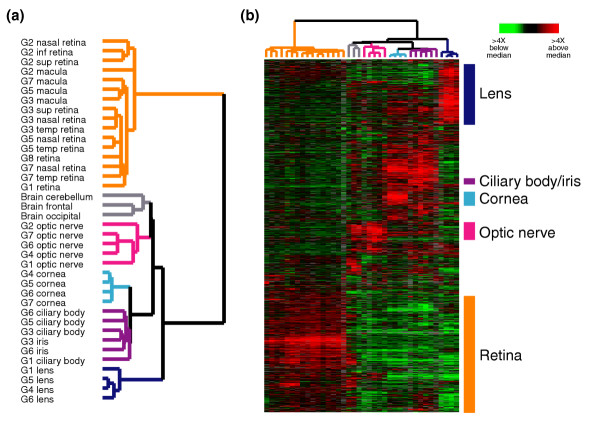
Gene expression programs in the human eye. Unsupervised hierarchical clustering of 38 samples from human cadaver eyes and normal brain. Array elements that varied at least 2.5-fold from the median on at least two microarrays were included (9,634 cDNA elements representing approximately 6,600 genes). (a) Array dendrogram. G1 to G8 indicate the globes from which each compartment sample was dissected (see Materials and methods). Inf., inferior; Sup., superior; Temp., temporal. (b) Cluster image. Data are displayed as a hierarchical cluster where rows represent genes (unique cDNA elements) and columns represent experimental samples. Colored pixels capture the magnitude of the response for any gene, where shades of red and green represent induction and repression, respectively, relative to the median for each gene. Black pixels reflect no change from the median and gray pixels represent missing data. Compartment-specific gene signatures are indicated. See our website for a searchable version of this cluster [75].